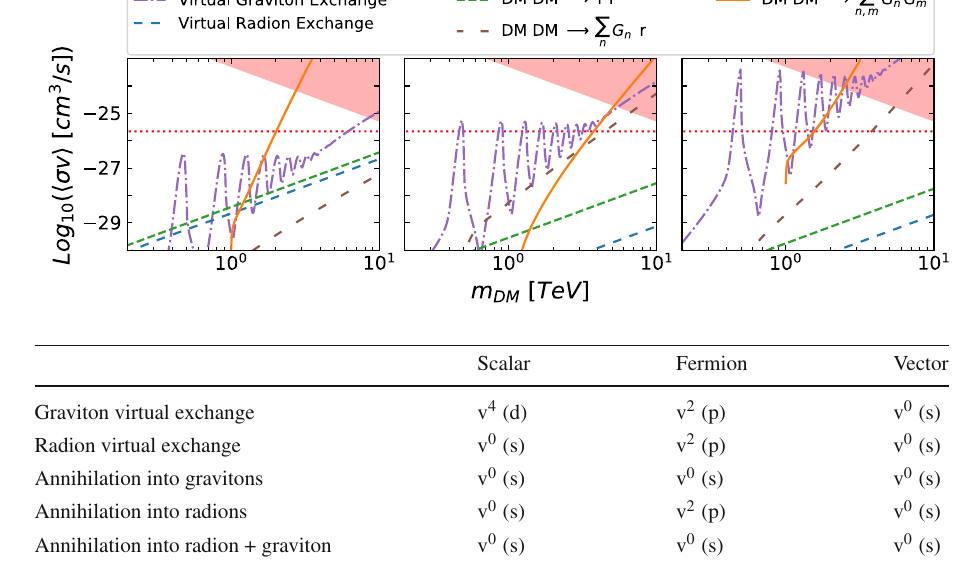
the different DM annihilation channels and the corresponding s -, p - or d -waves